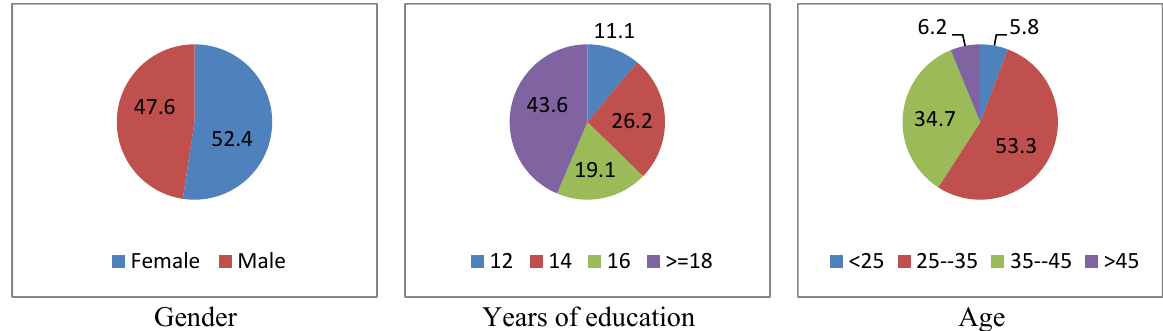
Fig. 1. Personal characteristics of the